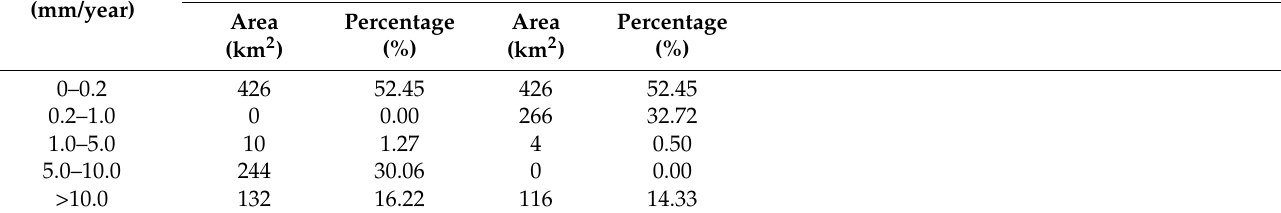
(Table 5). For Group 1 (1978 vs. 2009): In 1978, 90.23% of the basin experienced